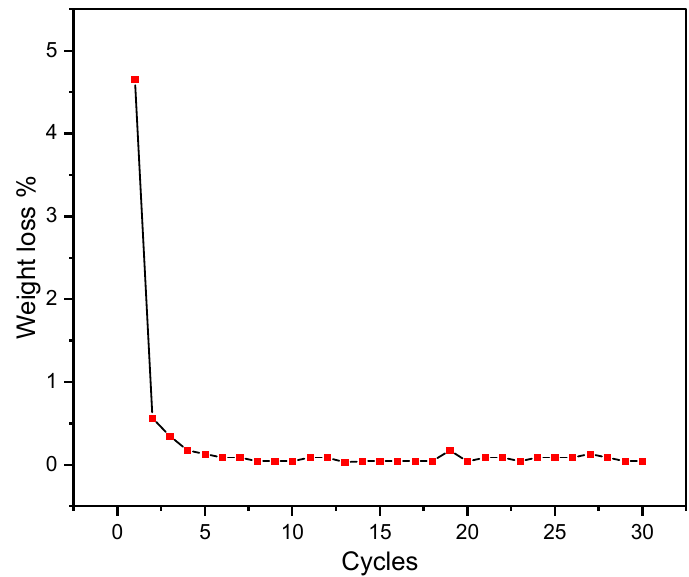
Figure 6. Weight loss % of 32 mol% LiCl-68 mol% LiOH shown for each